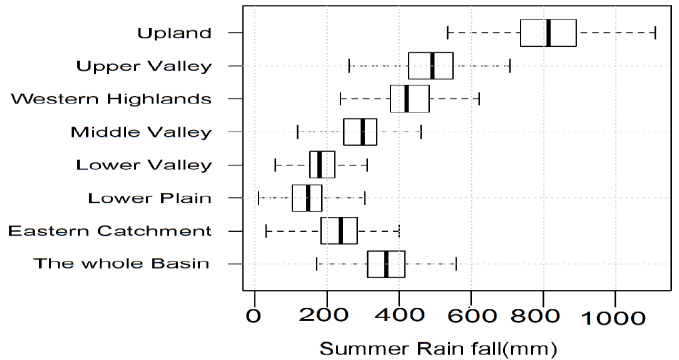
Figure 9. Box plot showing the variability of summer rainfall over the study areas for the period 1900 – 2016.